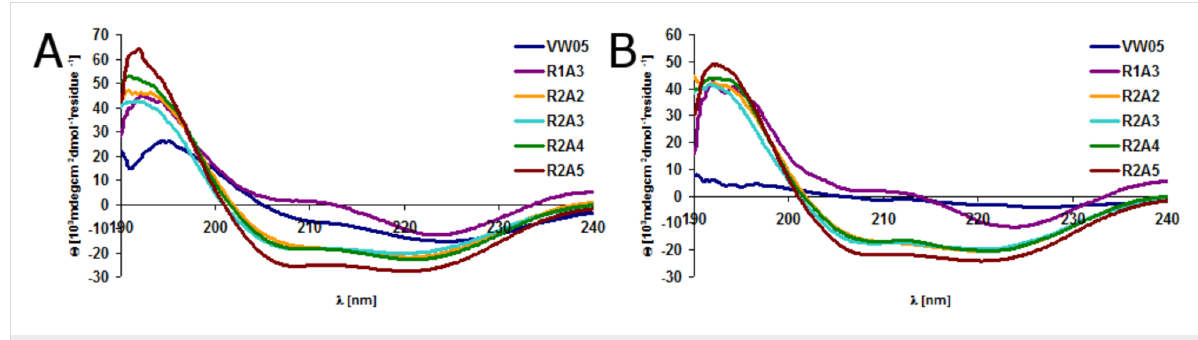
Figure 5: CD spectra of 15 µM peptide in the presence 0.05 µM Au/MUA nanoparticles at pH 9 after (A) 0 hours and (B) three hours.